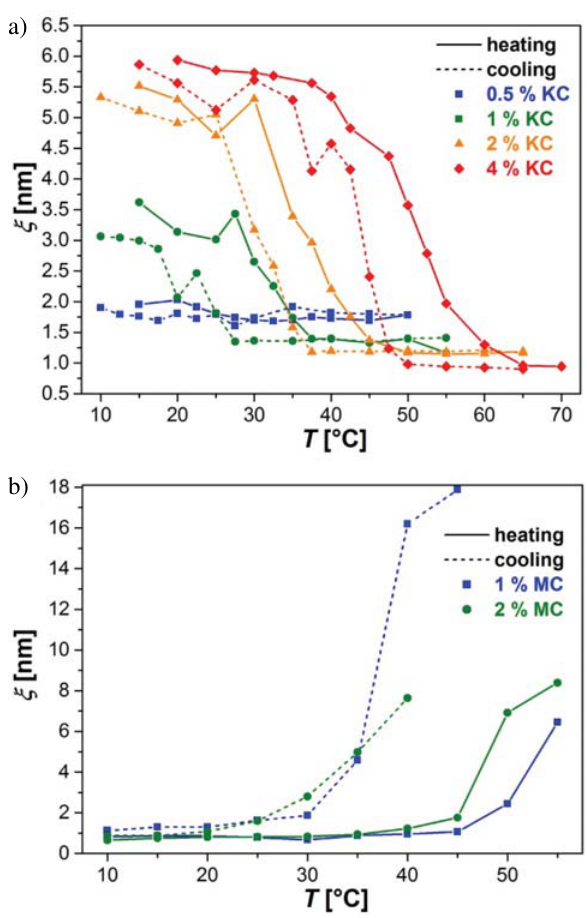
Figure 6: The temperature dependence of the dynamic correlation length ξ for polymer solutions of (a) KC and (b) MC at different concentrations.